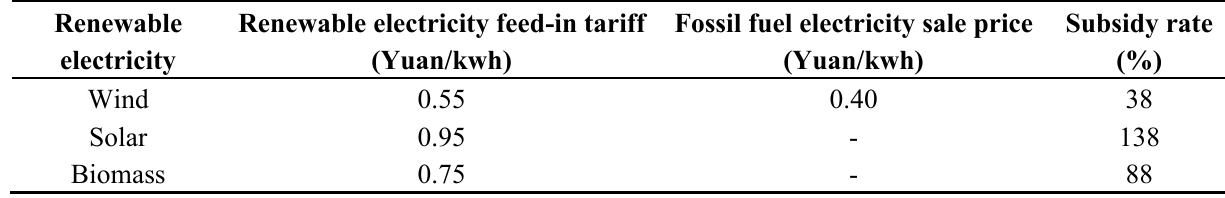
Table 2. The feed-in tariff and subsidy rate for the renewable during the study